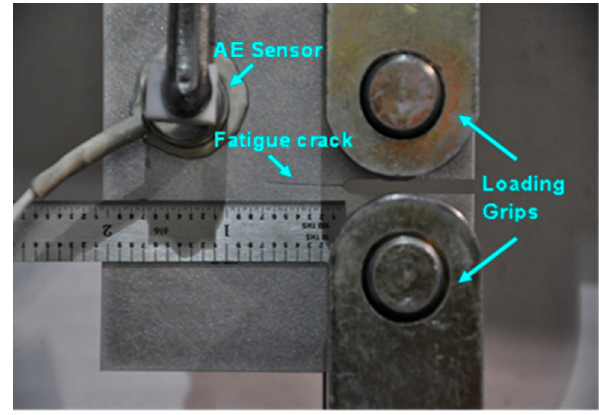
Figure 3. Standard CT specimen with a mounted AE sensor.